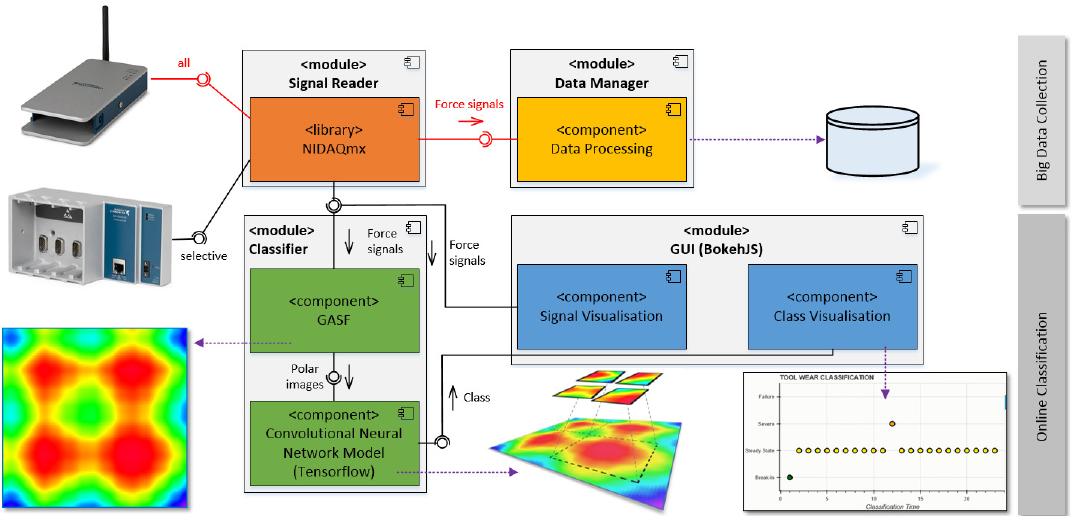
Figure 3. The computing architecture for real-time tool wear classification. The big data collection comprises the Signal Reader and the Data Manager modules to sample force values and externally store them. The tool wear classification comprises the Signal Reader , the Classifier and the GUI modules that selectively sample force values and classify